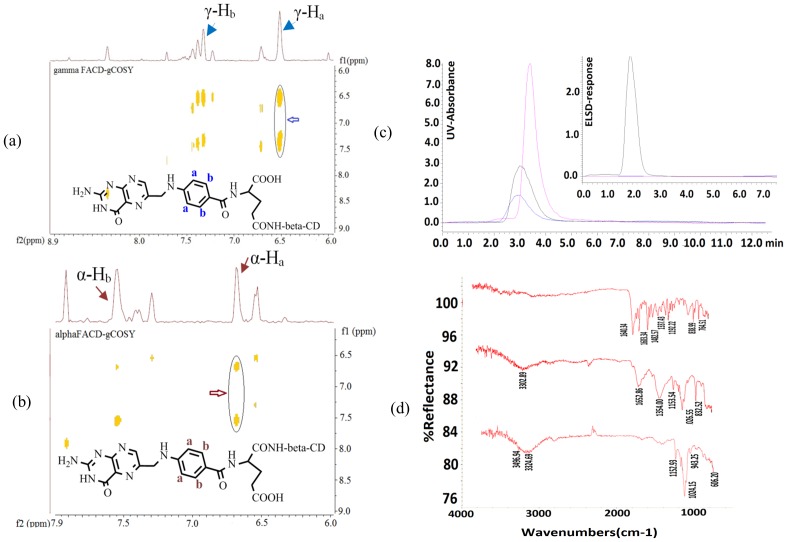
The g-COSY NMR (600 MHz, D2O, T = 298 K), UV/ELSD and FTIR spectra of the β-CD, NH2-CD, and γ- & α-FACDs.The NMR spectra show two pairs of correlated peaks (solid circle) between aromatic protons (γ substituted FACD protons in blue in Plot a and α-FACD in red in Plot b) of folic acid framework labeled with a and b. Plot c shows the HPLC-UV and ELSD chromatograms of β-CD (black), NH2-CD (blue) and γ-FACD (purple). Plot d illustrates the FTIR spectra of FA (top), γ-FACD (middle) and NH2-CD (bottom) (d).